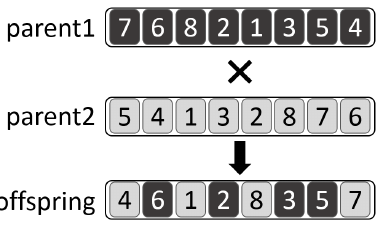
Figure 7. Order-based crossover